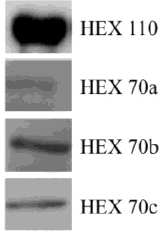
Figure 2. Hexamerins detected by western blot analysis in isolated fat body